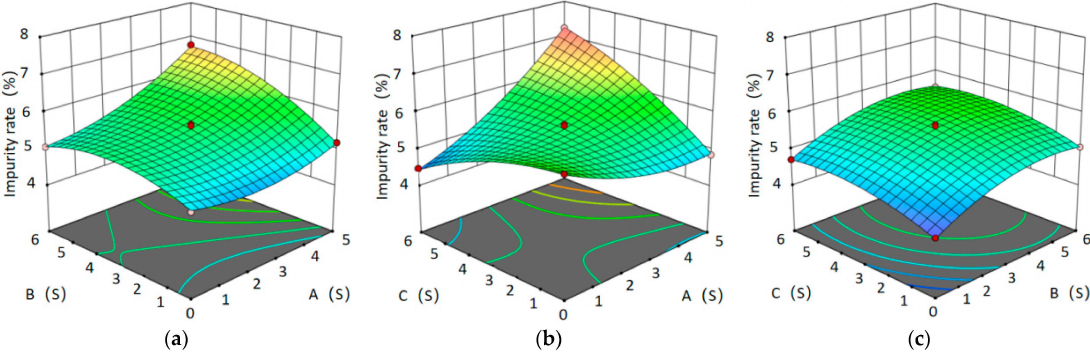
Figure 19. Influence of test factors on the impurity rate of pan-fried green tea materials in the No. 2 lower-level material outlet. ( a ) Effect of No. 3 and No. 5 baffle on impurity rate; ( b ) Effect of No. 3 and No. 6 baffle on impurity rate; ( c ) Effect of No. 5 and No. 6 baffle on impurity